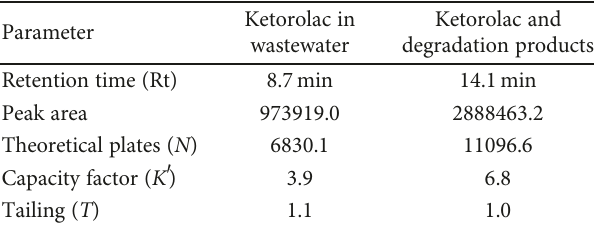
Table 1: Suitability results for the system.